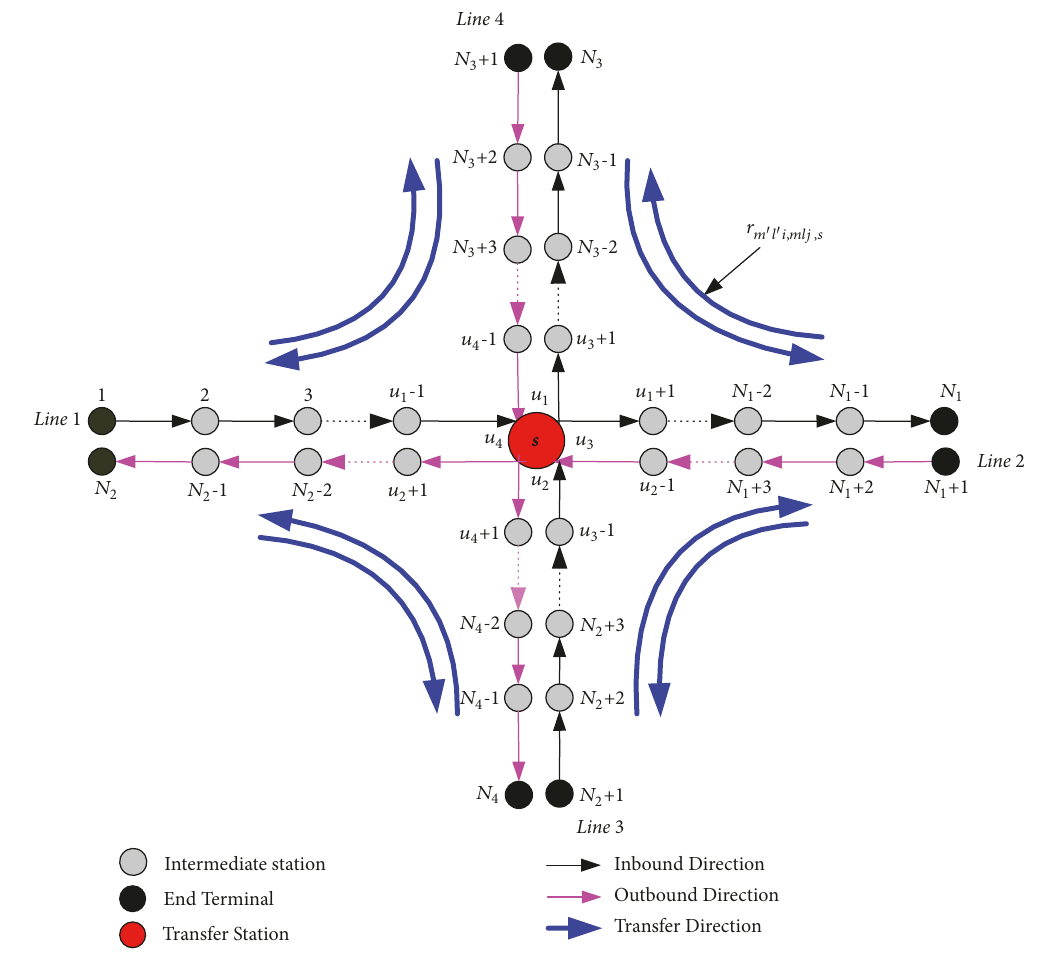
Figure 1: Configuration of a general transfer station.